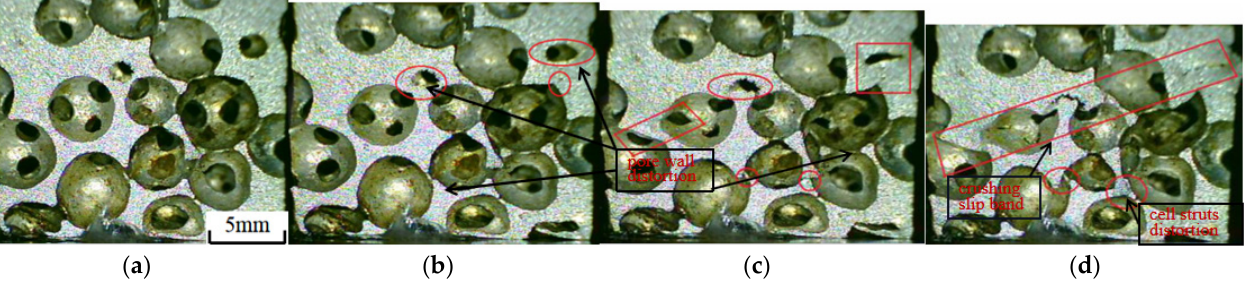
Figure 15. Surface images of the specimen during fatigue test (k = 1.2): ( a ) 0 strain; ( b ) 5% strain; ( c ) 10% strain ; ( d ) 12% strain .